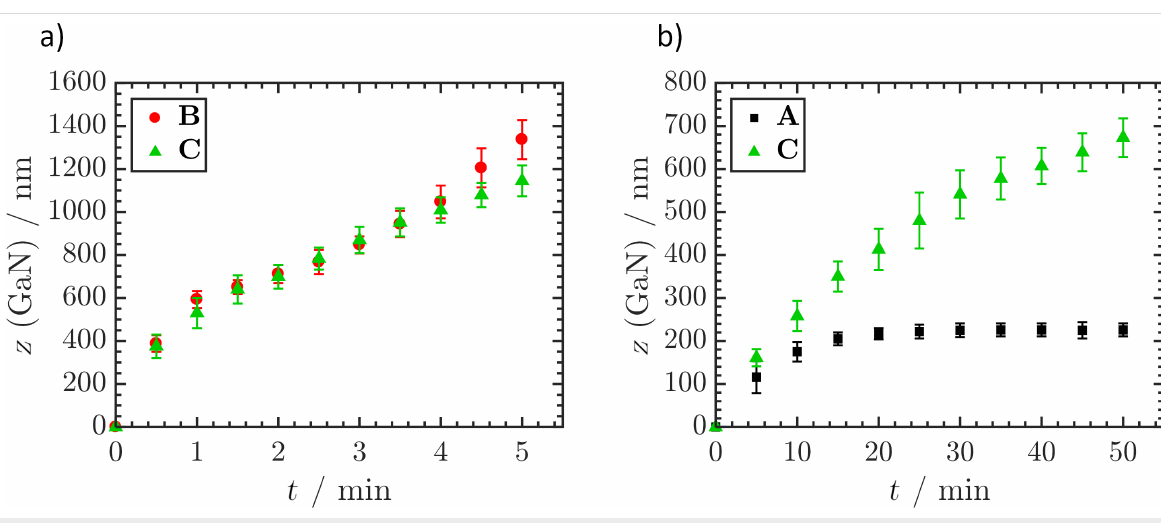
Figure 6: ICP-OES determined average GaN removal z (GaN) of B and C during etching in 30 wt % KOH at 80 °C (a) and A and C during etching in 30 wt % KOH at RT (b). Values were determined as mean ± SDM, n = 3.